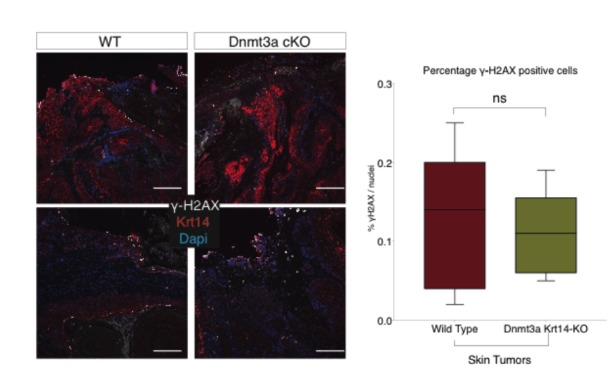
DOI:
http://dx.doi.org/10.7554/eLife.21697.034